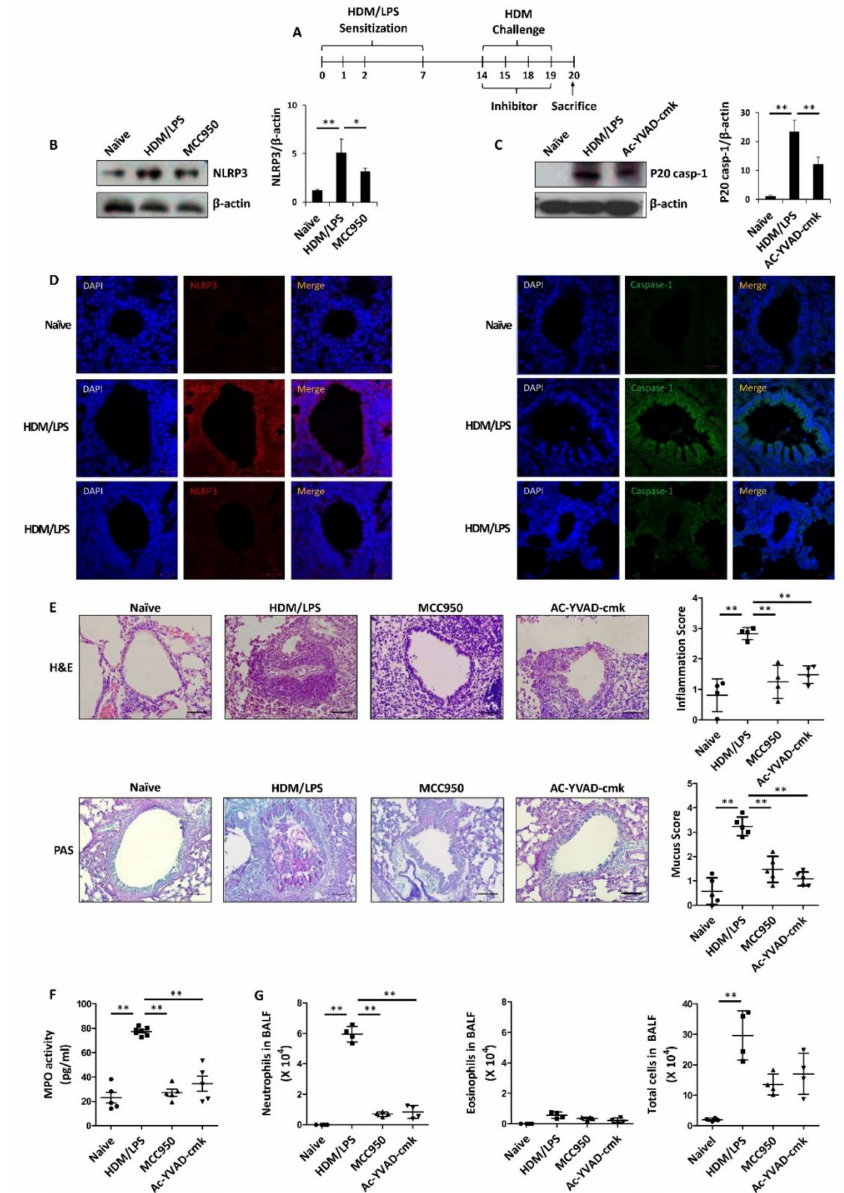
Figure 1. HDM/LPS-driven neutrophilic airway inflammation is dependent on NLRP3 stimulation. For the experiment, we administered the control (DMSO), MCC950 (10 mg/kg) or Ac-YVAD-cmk (1 mg/kg) via i.p. injection 1 h before every challenge ( n = 4–7 per group). Naïve designates control without any additions. ( A ) Scheme of the HDM/LPS-driven neutrophilic airway inflammation model. Airway inflammation was induced by the immunization with LPS (10 µ g)/HDM (100 µ g) in 25 µ L of saline and the challenge with HDM (50 µ g) in 25 µ L of saline. ( B , C ) The mouse lungs were homogenized and proteins were isolated to assess the levels of NLRP3 or caspase-1 by Western blotting. Data are representative of three independent experiments with similar results. ( D ) Immunofluorescence staining were done in lung tissues for detecting NLRP3 (red, CYTM3) or caspase-1 (green, FITC). Nuclei were stained with DAPI (blue; 400 × ). The images are representative of three independent experiments with similar results. ( E ) H&E and PAS staining of the lungs. Perivascular and peribronchial lung inflammation as well as mucus secretion were determined and scored (400 × ). Data are shown as the mean ± SD ( n = 4–5 per group). ( F ) MPO levels were analyzed in lung lysates using ELISA. ( G ) The numbers of neutrophils and eosinophils as well as total immune cells were obtained in BALF using Cytospin and then stained with Diff-Quik. Data are shown as the mean ± SD ( n = 4 per group). All experiments were performed in triplicate. * p < 0.05, ** p < 0.01 versus each control